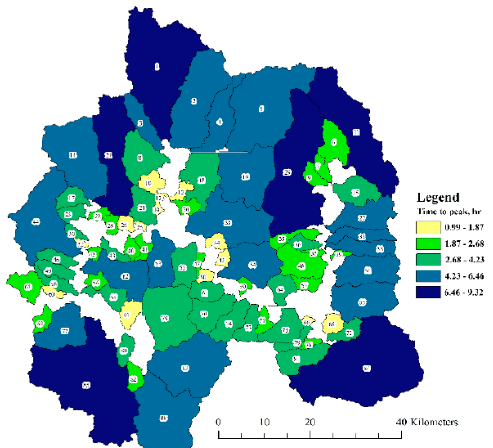
Figure 11. Peak discharge of sub-watershed in the study.